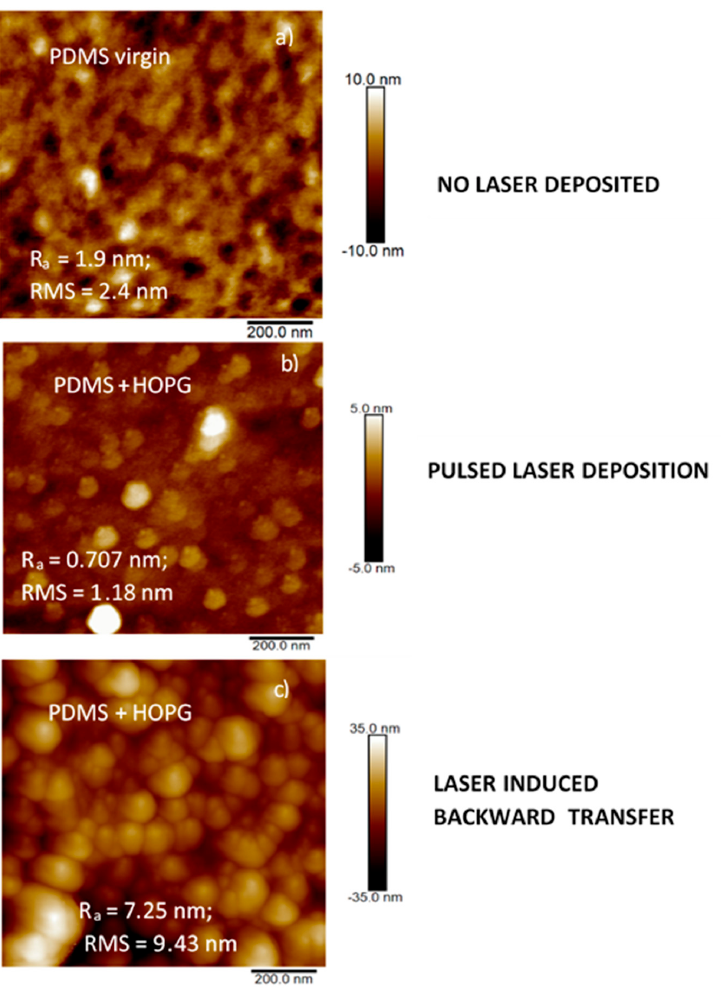
Figure 7. AFM topography image (field view 1 µm) for virgin PDMS ( a ), PDMS deposited with HOPG by PLD ( b ) and PDMS deposited with HOPG by LIBT ( c ). The difference between the surface (basic) of the investigated area and the rough sur- face (real) in the investigated area increased from 1.10% in HOPG deposited on PDMS by PLD to 6.75% in HOPG deposited on PDMS by LIBT, respectively. This trend points out